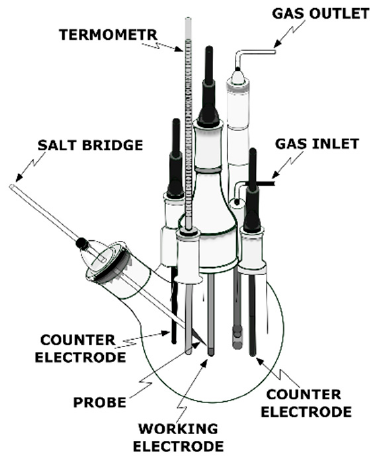
Figure 12. The apparatus for the bubble test